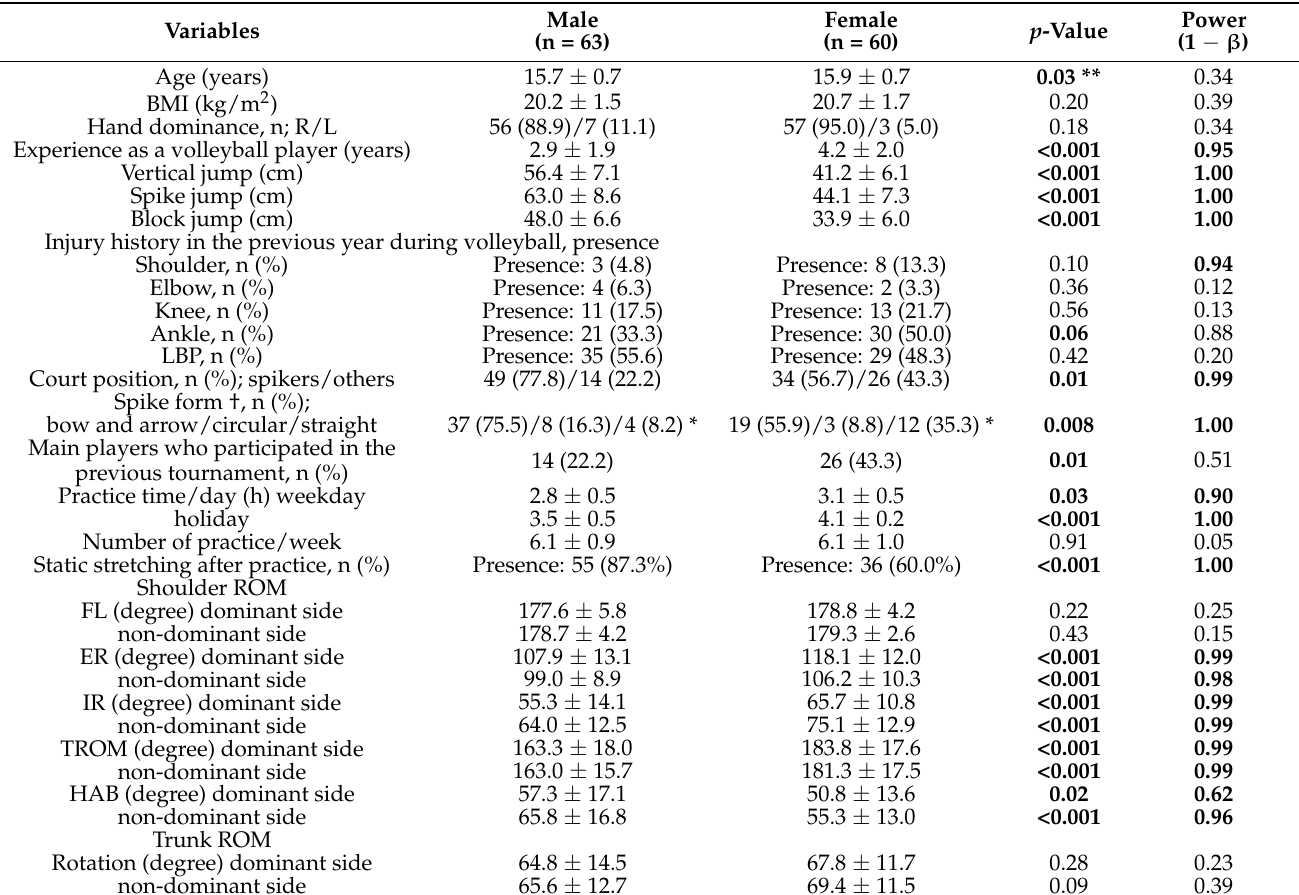
Table 4. Sex differences in questionnaire items and shoulder and trunk